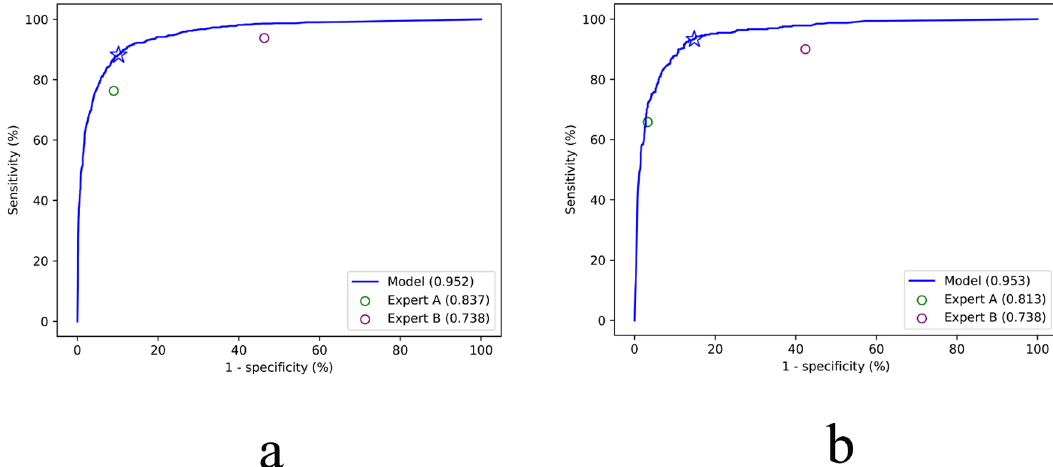
Fig. 1 The ROC curves of the ensembled deep learning models for the diagnosis of biliary atresia on the internal cross-validation dataset with two human experts ’ performance for comparison. a The ROC curve of the model at the image level. b The ROC curve of the model at the patient level. The performance of the two experts is represented by individual solid circle, which is inferior to that of the ensembled deep learning model. The blue star represents the performance of the model with the default threshold (0.5) to binarize outputs of the model. Source data are provided as a Source data fi le. ROC receiver operating